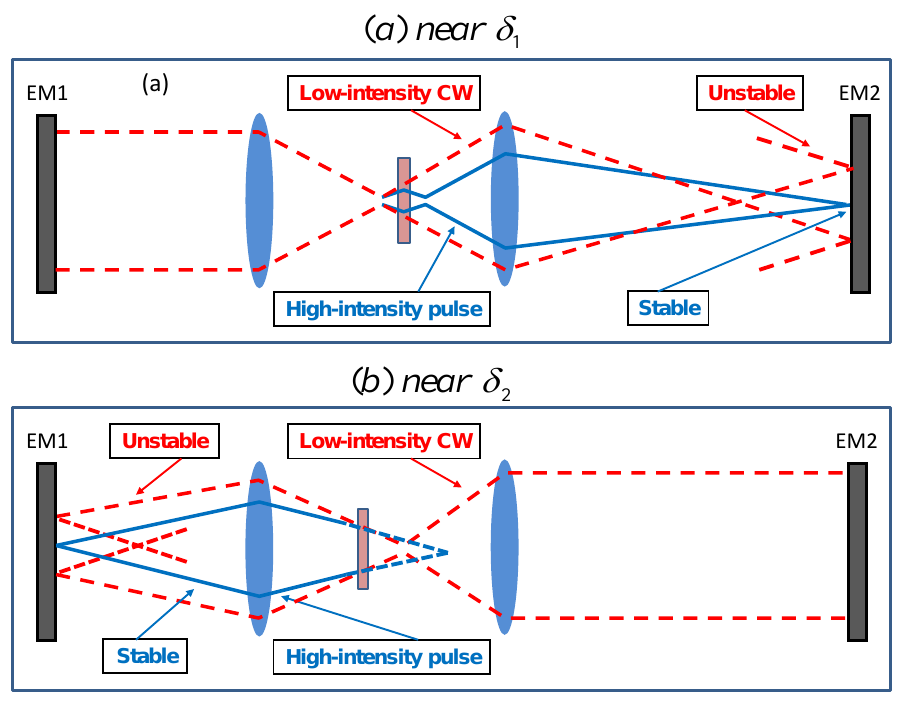
Figure 6. Illustration of the Kerr lensing effect as a mode-locking stabilizing mechanism in virtual hard aperture technique: ( a ) increasing δ beyond the stability limit, δ CW operation, while ML operation remains stable as the effective distance between f f becomes shorter, by the nonlinear forward imaging of the focus point; ( b ) decreasing δ 2 below the stability limit, δ , destabilizes CW operation, while ML operation remains stable 2 as the effective distance between f and f becomes larger by nonlinear virtual imaging of 1 2 the focus